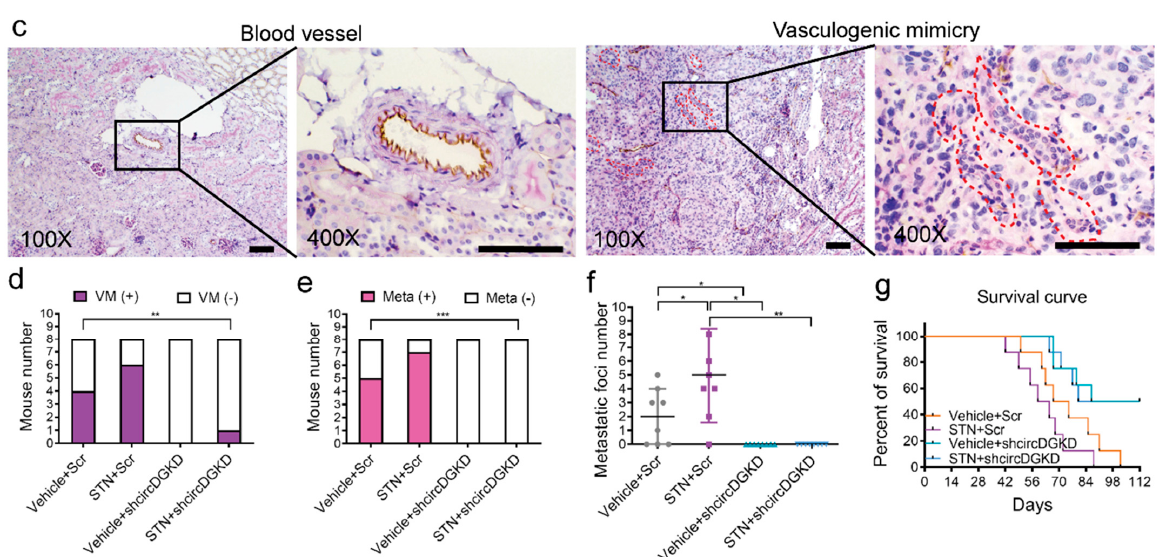
Figure 6. Orthotopic mouse model studies confirmed that shcircDGKD intercepts the sunitinib-pretreatment-induced RCC VM formation, reduces metastases, and improves survival. ( a ) Schematic diagram demonstrating orthotopic mouse model implanted with 786-O-Luc-Scr vs. 786-O-Luc-shcircDGKD cells pretreated with or without 1 µ M sunitinib (STN). ( b ) Representative IVIS images of four groups of female nude mice at week 8. ( c ) CD31/PAS double staining comparison between blood vessels in kidney tissue and VM in tumor xenografts. ( d – f ) Comparisons of numbers of mice between four groups with VM (+) vs VM ( − ) ( d ), with positive metastasis [Meta (+)] vs. negative metastasis [Meta ( − )] ( e ), and metastatic foci number per mouse ( f ). ( g ) The survival length comparison between the four groups of mice. Scale bar, 100 µ m. Data are presented as mean ± SEM. * p < 0.05, ** p < 0.01, *** p < 0.001.